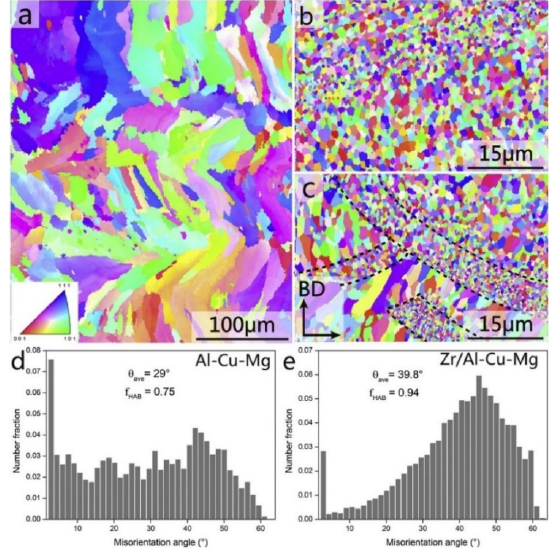
Figure 53. EBSD inverse pole figure (IPF) maps of Al-Cu-Mg fabricated at a scanning speed of 5 m/min ( a ) and Zr/Al-Cu-Mg sample fabricated at a scanning speed of 5 m/min ( b ) and 15 m/min ( c ), respectively. ( d , e ) misorientation angle distribution [190]. Copyright 2017. Adapted with permission